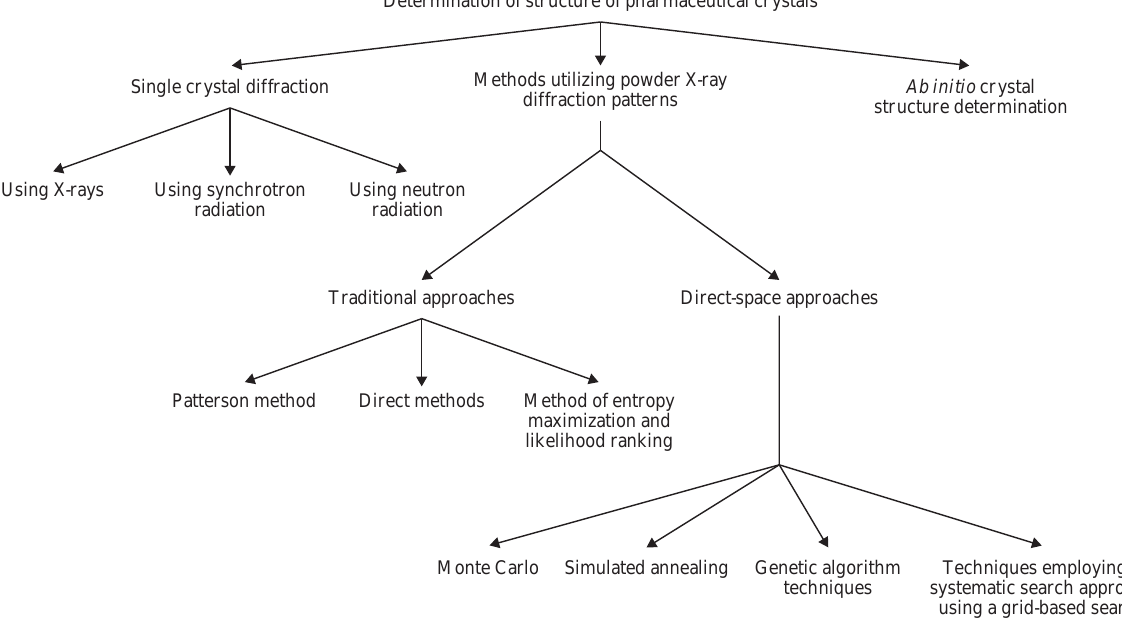
Table 2 Classification of methods used to determine structures of pharmaceutical